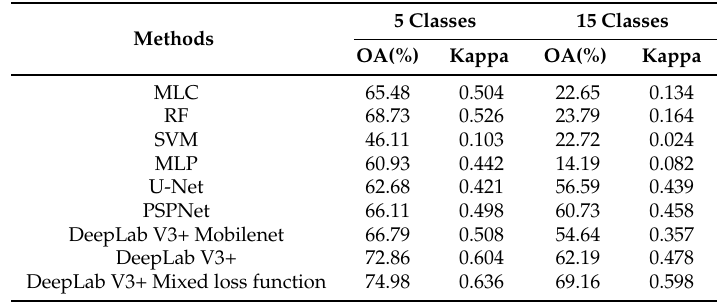
Table 6. Experiment results of models with different structure on GID